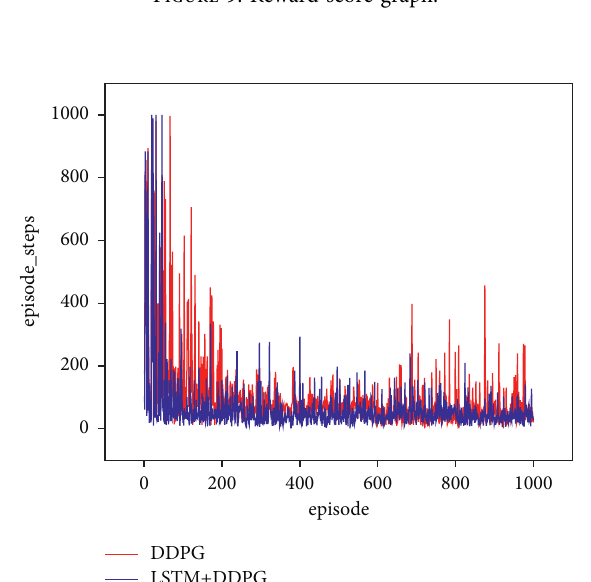
Figure 9: Reward score